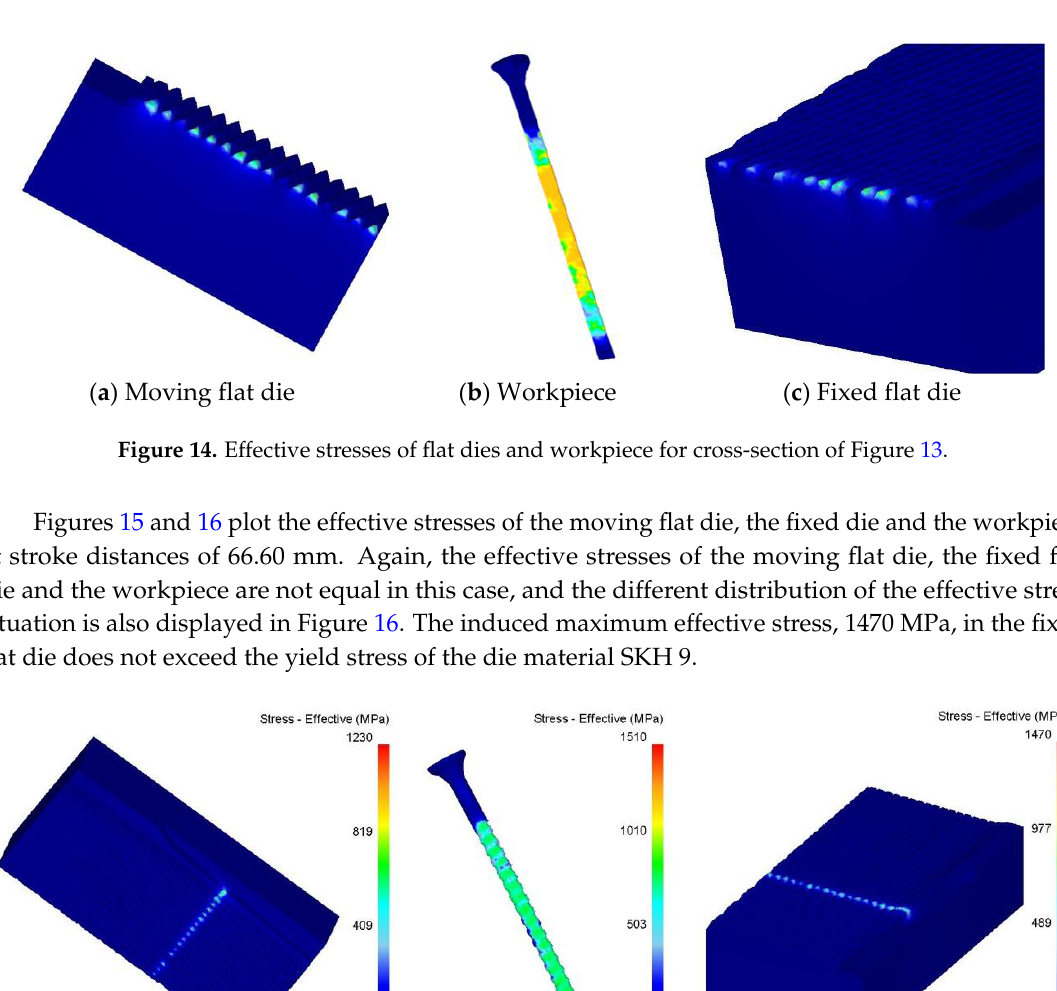
Figure 13. Effective stresses of flat dies and workpiece at a stroke distance of 8.89 mm.